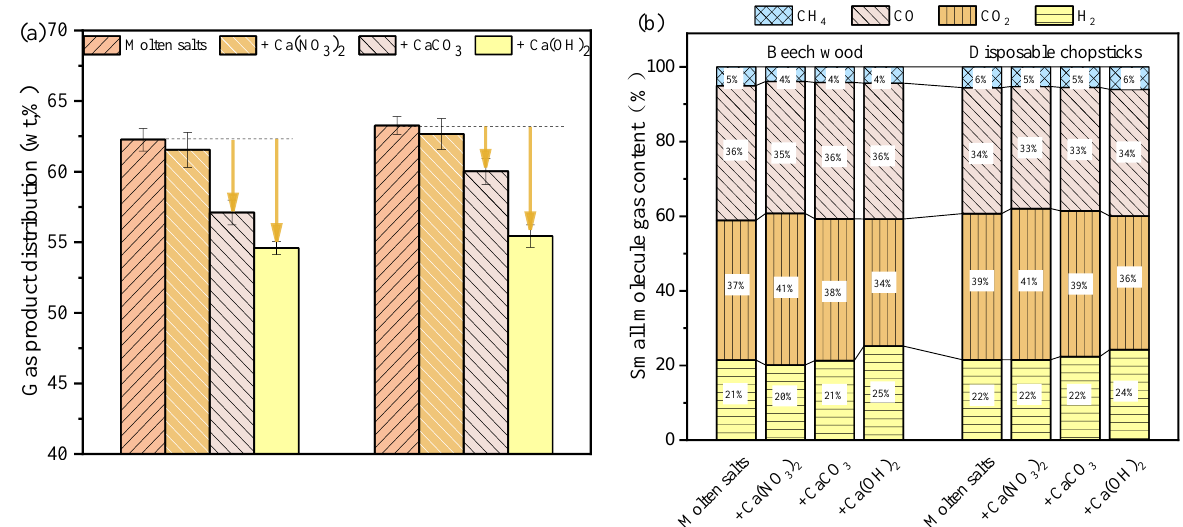
Figure 4. The distribution characteristics of gaseous products in molten salts pyrolysis. ( a ) Gas yield, ( b ) distributions of small molecules